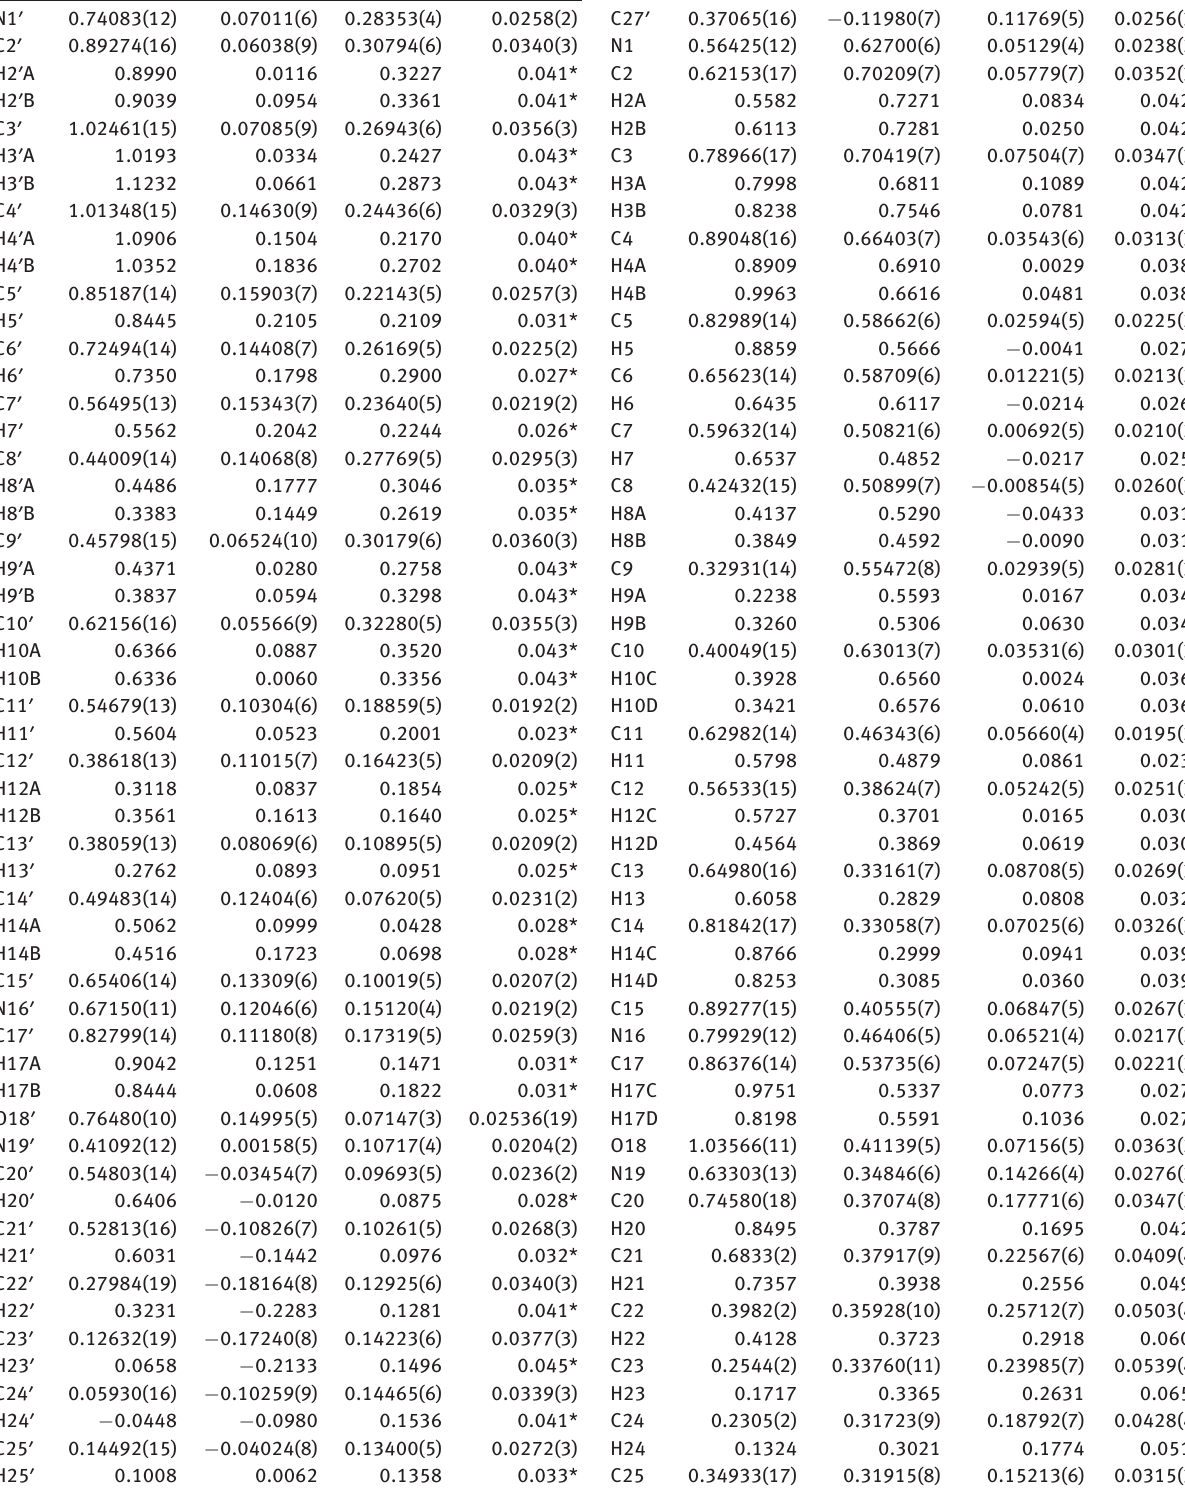
Table 2: Fractional atomic coordinates and isotropic or equivalent isotropic displacement parameters (Å 2